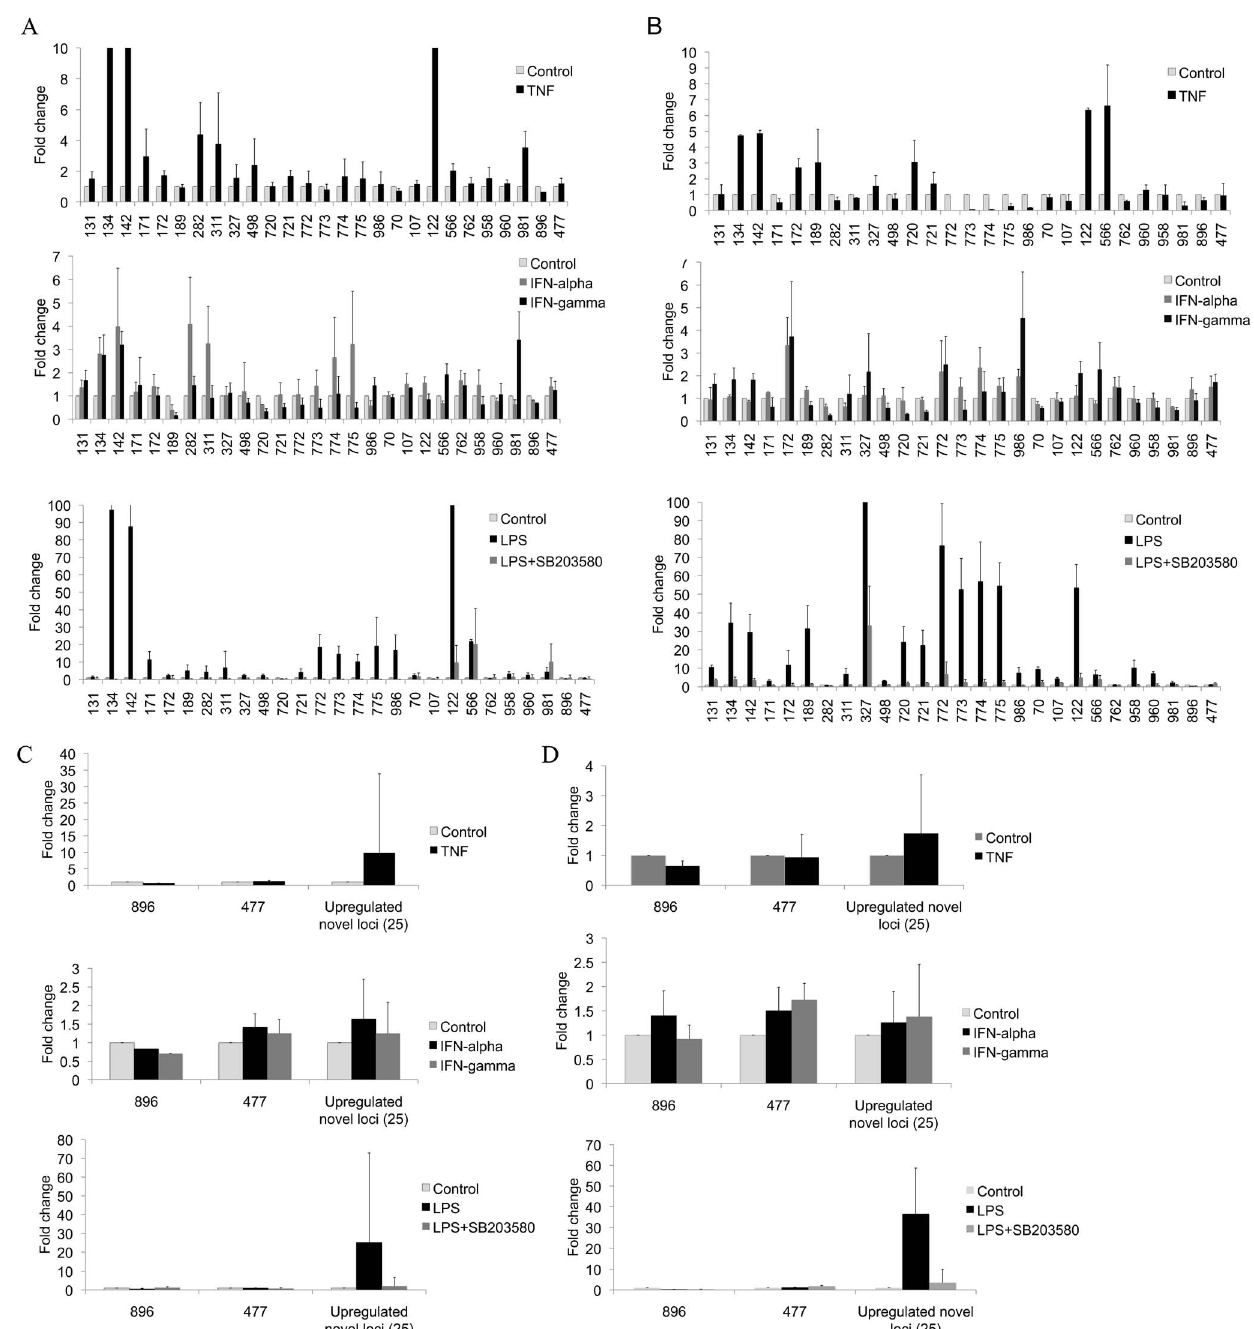
Figure 4. LPS stimulation of monocytes. A) MonoMac 6 cells were stimulated for 16 hours as indicated and qRT-PCR was performed for the novel loci. Only LPS (1 m g/ml) stimulation consistently upregulated these loci. TNF- a (10 ng/ml) led to upregulation of 16/25 (fold change . 1.5), a IFN (100 U/ml) led to upregulation of 9/25 (fold change . 1.5), c IFN (10 ng/ml) led to upregulation of 5/25 (fold change . 1.5), and LPS led to upregulation of 22/25 (fold change . 1.5). Three experiments with duplciates or triplicates were averaged. The error bars indicate standard deviation. B) Human primary monocytes were stimulated as above and the abundance of the novel transcripts quantitated by qRT-PCR. TNF- a led to upregulation of 9/25 (fold change . 1.5), a IFN led to upregulation of 7/25 (fold change . 1.5), c IFN led to upregulation of 9/25 (fold change . 1.5), and LPS led to upregulation of 23/25 (fold change . 1.5). Pre-treatment of cells with the p38 inhibitor, SB203580 led to markedly diminished induction of expression by LPS. Three experiments with duplciates or triplicates were averaged. The error bars indicate standard deviation. C) The average fold change for the aggregated novel upregulated loci in SLE were calculated for MonoMac 6 cells and D) healthy human primary monocytes stimulated by LPS, TNF- a , a IFN,or c IFN. Locus 896 was down-regulated and locus 477 was not changed in the orignal SLE samples and were included as controls. The error bars indicate standard deviation in C and D.